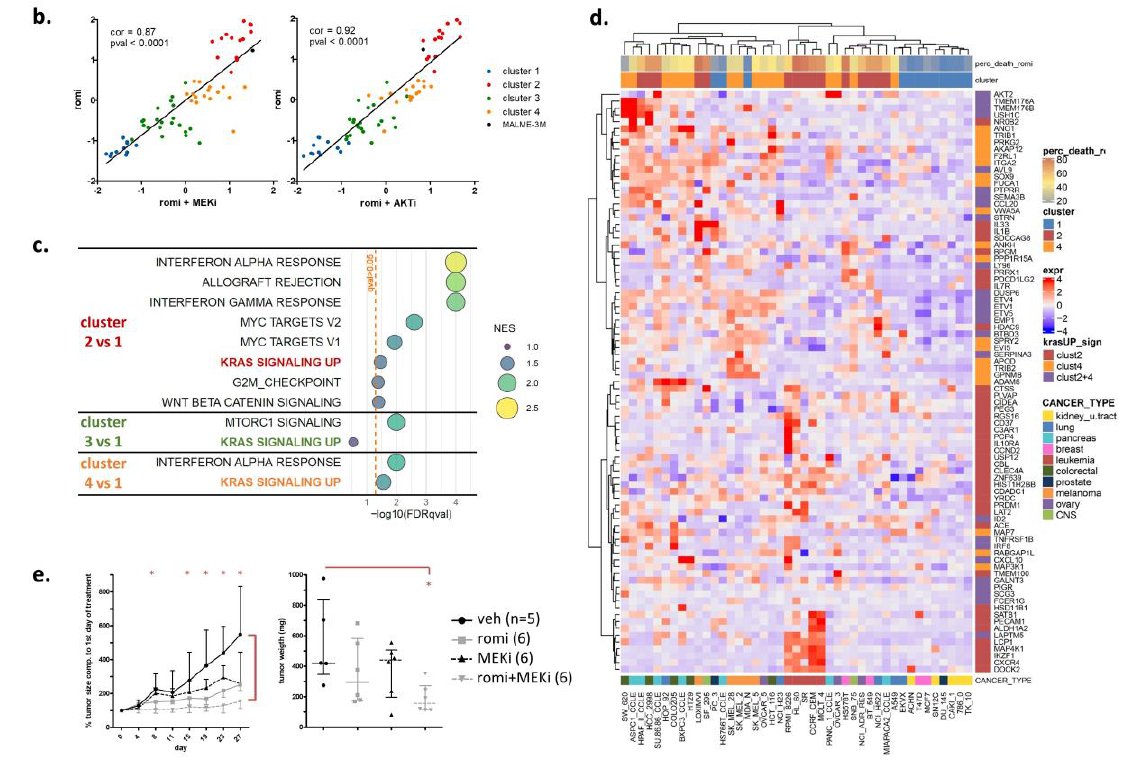
Figure 1. Activated RAS pathway is linked to romidepsin sensitivity. ( a ) Cells were treated with romidepsin (clinical dosing) and/or MEK inhibitor (MEKi, 250 nM) and/or AKT inhibitor (AKTi, 1 µ M), and cell death was assessed at 48 h by annexin V-PI assay. Cell lines with a high expression of the multidrug efflux transporter P-glycoprotein were cotreated with P-gp inhibitor Tariquidar (Tq) to avoid the bias of drug efflux during the assessment of toxicity. Cells were hierarchically clustered according to percentage cell death, and a heatmap was drawn accordingly. Key DNA mutations and tissue origin of cancer are indicated below the heatmap. ( b ) The response to romidepsin in combination with either MEKi ( left ) or AKTi ( right ) for the 65 cell lines were plotted according to response to romidepsin alone (z-score). Cells were colored according to the four clusters obtained in ( a ). ( c ) SAM analysis was performed on NCI-60 panel gene expression between low responsive cluster (cluster 1) and each of the three others. SAM-ranked genes were analyzed with GSEA, and the significant enriched gene sets (FDR q-value < 0.05) obtained for each cluster was plotted according to normalized enrichment score (NES) and false discovery rate (FDR). ( d ). Leading-edge genes for “KRAS signaling up” signature obtained by GSEA analysis in clusters 2 and 4 were hierarchically clustered according to their basal expression in the 65 cell lines. ( e ) Athymic mice were injected with KRAS mutation bearing A549 cells forming tumor, then treated with romidepsin and/or MEKi for 28 days. Tumor size (median ± IQR) and mice weight (Supplementary Figure S2c) were measured over time, and tumor weight (median ± IQR) was measured after mice sacrifice and tumor dissection. Statistical difference between control and treated groups was determined using Welch’s t -test (unequal variance t -test), with * indicating a p -value <